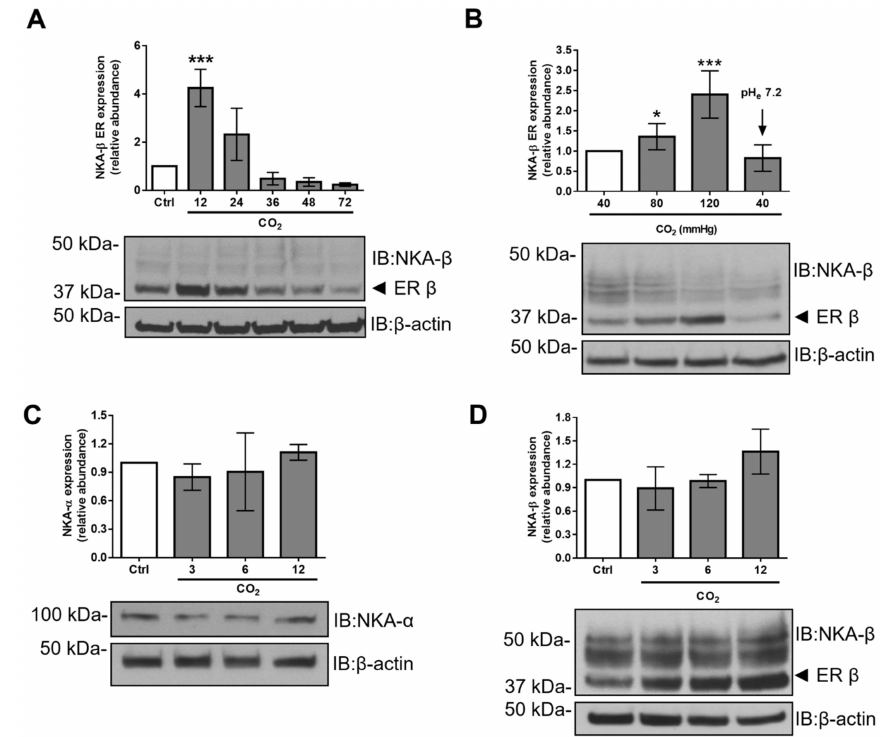
Figure 1. Hypercapnia increases Na,K-ATPase (NKA)- β abundance in the endoplasmic reticulum (ER). ( A ) A549 cells were exposed to 40 (Ctrl) or 120 mmHg CO 2 (CO 2 ) with an extracellular pH = 7.4 for the di ff erent time-points up to 72 h. Total cellular level of NKA- β was measured by immunoblotting. Representative immunoblots of NKA- β are shown. Bars represent ER-resident NKA- β / β -actin ratio. Values are expressed as mean ± SD ( n = 3, *** p < 0.001). ( B ) A549 cells were treated with 40, 60, 80, and 120 mmHg of CO 2 with an extracellular pH = 7.4 or to 40 mmHg CO 2 with a pH = 7.2 for 12 h. NKA- β levels were measured by immunoblotting. Representative immunoblots of NKA- β are shown. Bars represent total NKA- β / β -actin ratio. Values are expressed as mean ± SD ( n = 3, * p < 0.05, *** p < 0.001). ( C ) A549 cells were exposed to 40 (Ctrl) or 120 mmHg CO 2 (CO 2 ) with an extracellular pH = 7.4 for di ff erent time-points. Total cellular levels of NKA- α were measured by immunoblotting. Representative immunoblots of NKA- α are shown. Bars represent total NKA- α / β -actin ratio. Values are expressed as mean ± SD ( n = 3). ( D ) A549 cells were exposed to 40 (Ctrl) or 120 mmHg CO 2 (CO 2 ) for di ff erent time-points. Total cellular levels of NKA- β were measured by immunoblotting. Representative immunoblots of NKA- β are shown. Bars represent total NKA- β / β -actin ratio. Values are expressed as mean ± SD ( n =